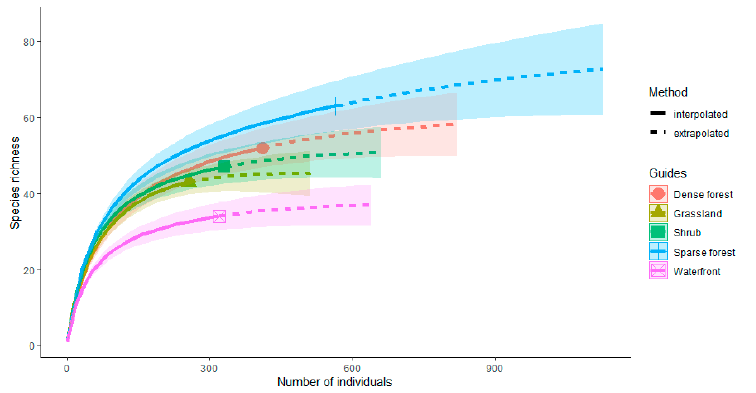
Figure 4. Comparison of individual-based interpolation (sparsity) and extrapolation of bird com- munities in different vegetation habitats in urban mountain parks under a multi-indicator model.